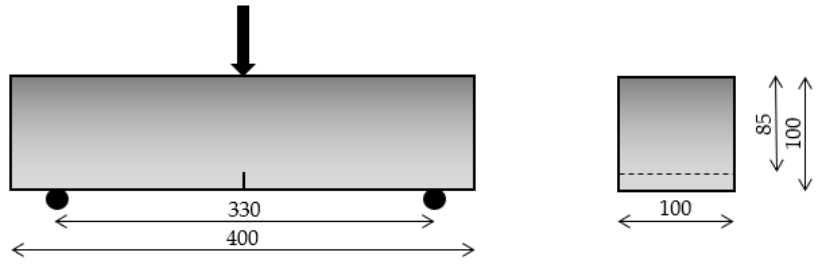
Figure 4. Scheme of the adapted three-point bending test.